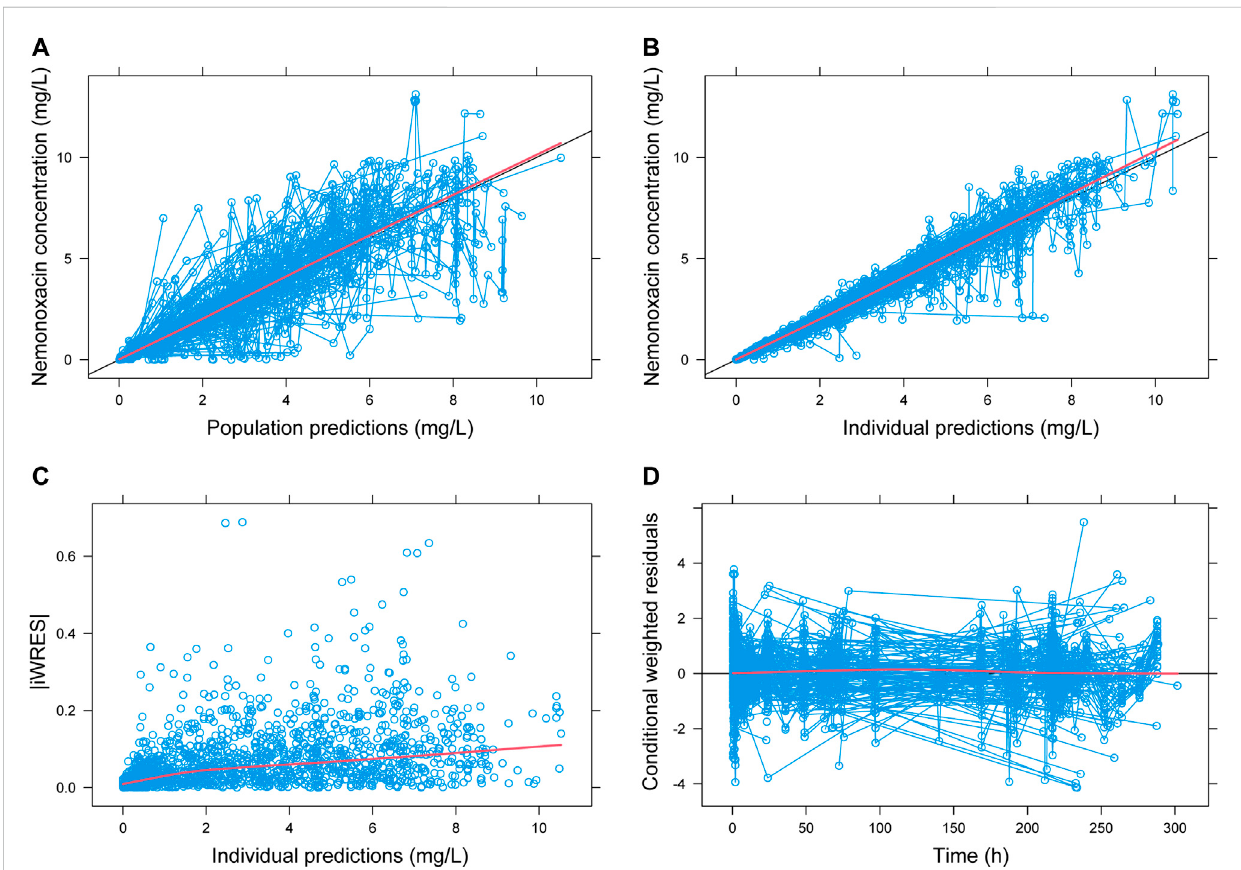
Goodness-of- fi t plot for population PK model of nemonoxacin. iWRES: individual weighted residual. Blue circle: actual data. Black line: unity line (A,B) or zero horizontal line (D) . Red line: locally weighted linear